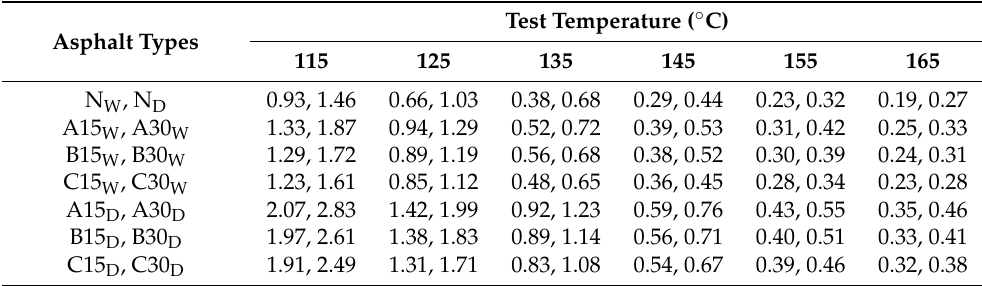
Table 3. Viscosity results of virgin and reclaimed asphalt